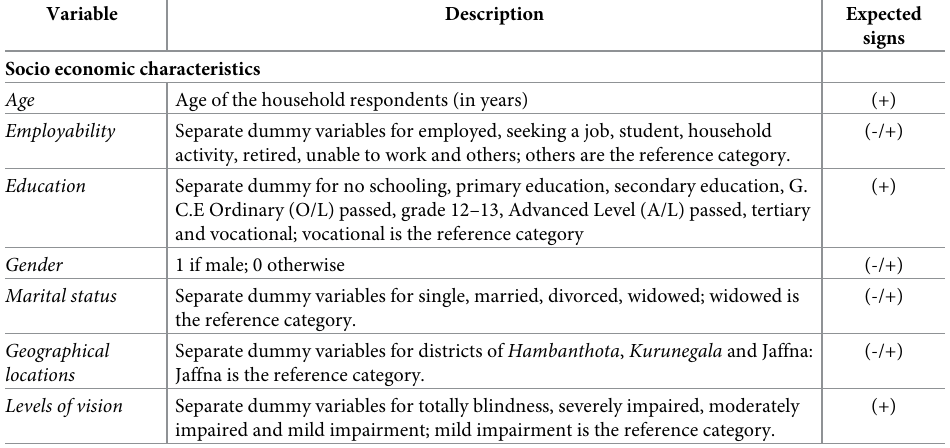
Table 2. Definitions of variables with the expected